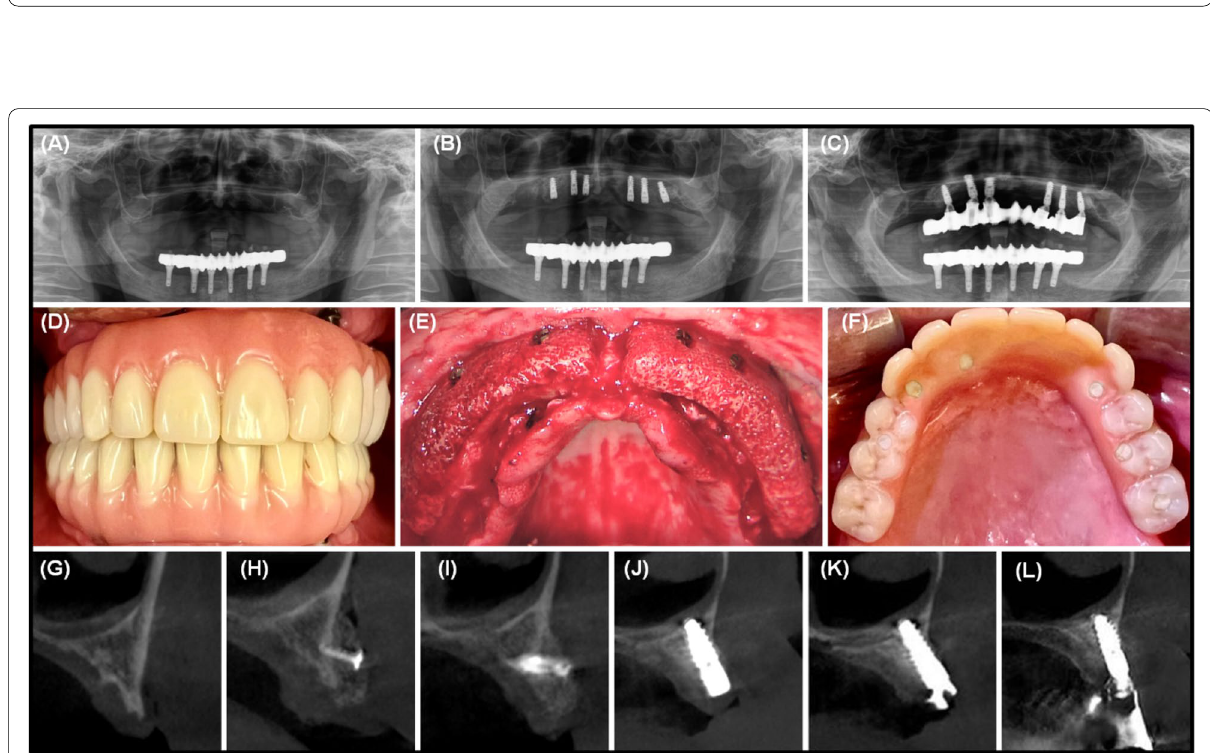
Fig. 4 A OPT from the preoperative situation; B OPT after the implantation; C OPT shows the final screw‑retained prosthetic construction; D clinical photo of the final rehabilitated maxilla (frontal view); E intraoperative image of two allogeneic individual 3D‑bone blocks with simultaneous bilateral external sinus lifts for the augmentative rehabilitation of the upper jaw; F clinical photo of the finally rehabilitated upper jaw (occlusal view); G – L radiological chronology of augmentative, implantological, and prosthetic rehabilitation of a highly atrophic maxilla using combined therapy with external sinus lifts and 3D‑milled bone blocks over a period of 19 months: G CBCT before augmentation (3 months); H CBCT after augmentation OP; I CBCT after augmentation (3 months); J CBCT after augmentation (12 months); K CBCT after augmentation (19 months); and L CBCT after augmentation (26